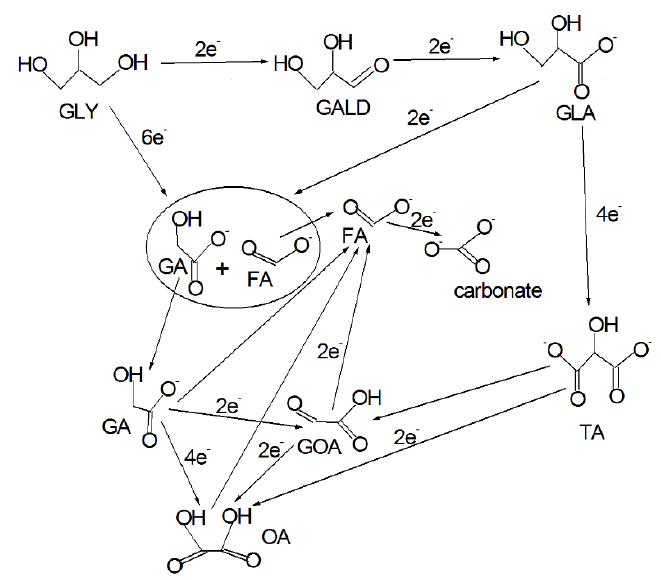
Figure 1. Representation of the possible pathways of GLY electrooxidation on precious metal and precious metal-based catalysts in an alkaline medium with C–C bond cleavage and in the absence of